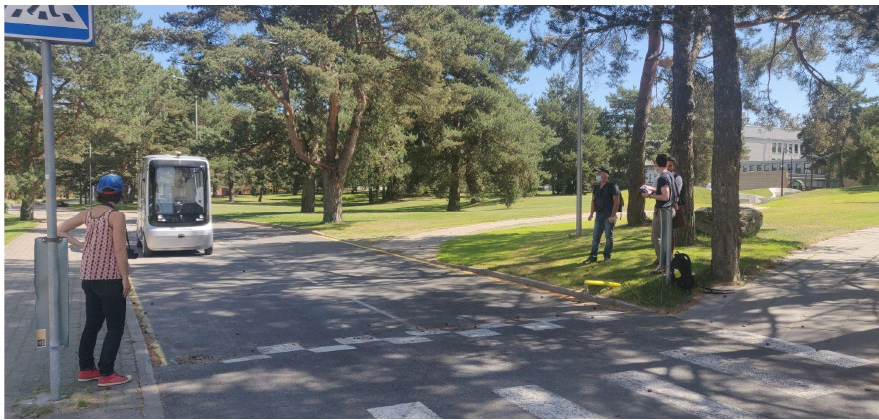
Figure 1. Typical pedestrian crossing scenario for AVs.